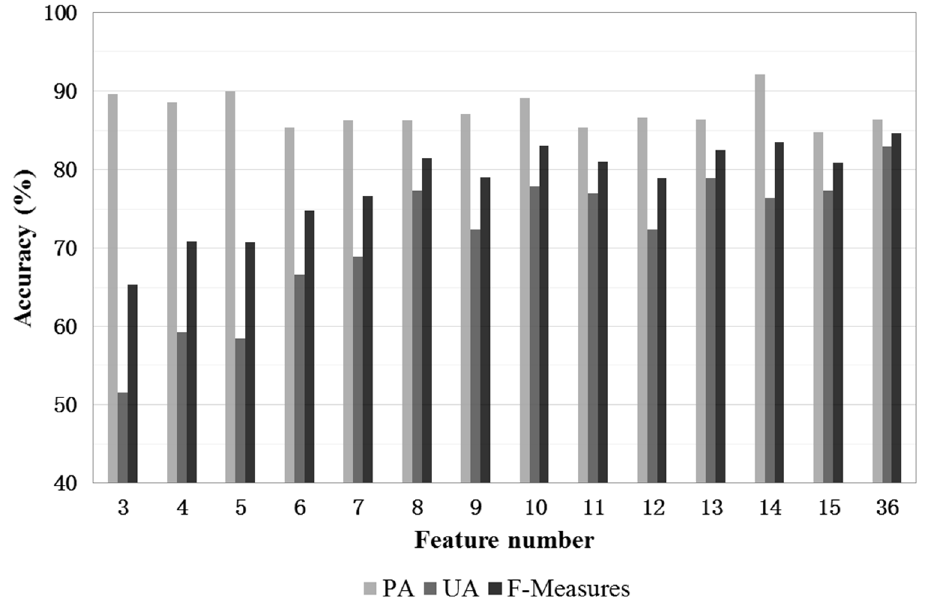
Figure 9. Evolution of classification accuracy related to the number of selected variables in Changwu.